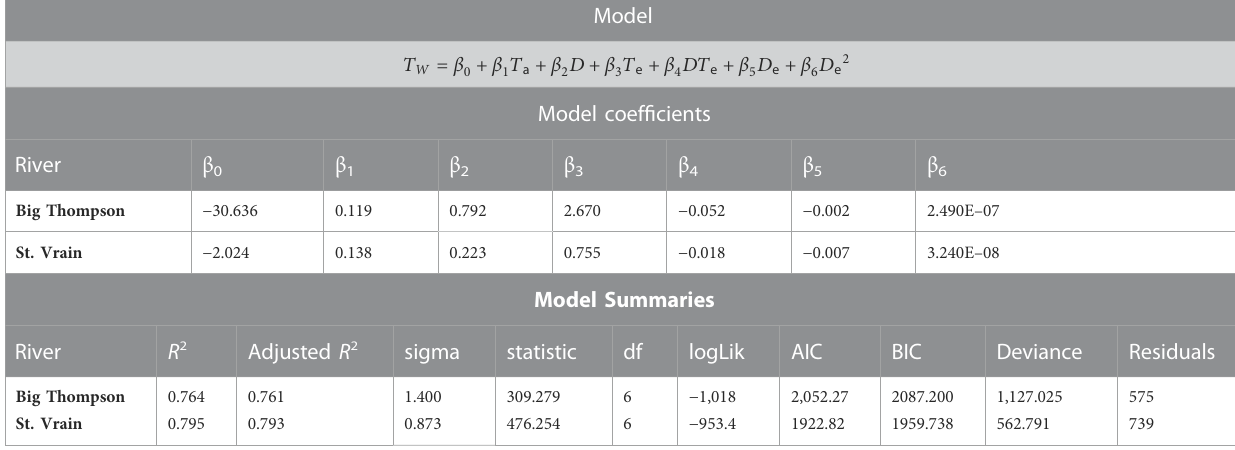
TABLE 1 Model coef fi cients and summaries for winter water temperature in the Big Thompson and St. Vrain downstream of the WWTP ef fl uent. All coef fi cients in the models were signi fi cant predictors of water temperature ( p < 0.05). T w is water temperature, T a is the air temperature ( ° C), D is the discharge (cfs), T e is the ef fl uent temperature ( ° C) and D e is the distance (m) from the WWTP ef fl